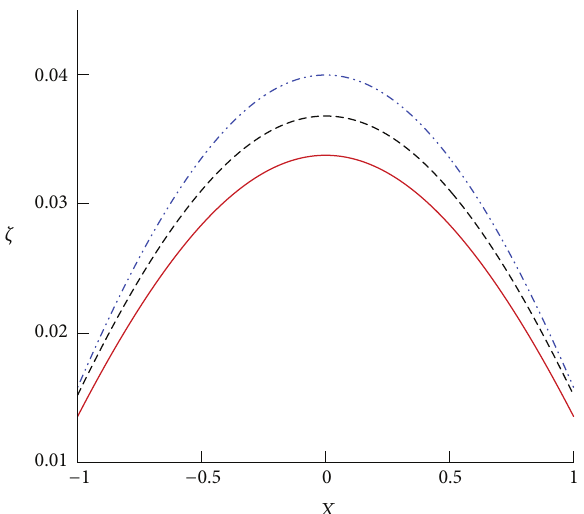
Figure 5: Variation of the plate deflection 𝜁(𝑋) near the crest versus 𝑋 for different Young’s moduli of the plate 𝐸 . Solid line: 𝐸 = 10 8 ; dashed line: 𝐸 = 10 9 ; dash-dot-dotted line: 𝐸 = 10 10 .